Question: Write a single sentence explaining what this figure depicts.
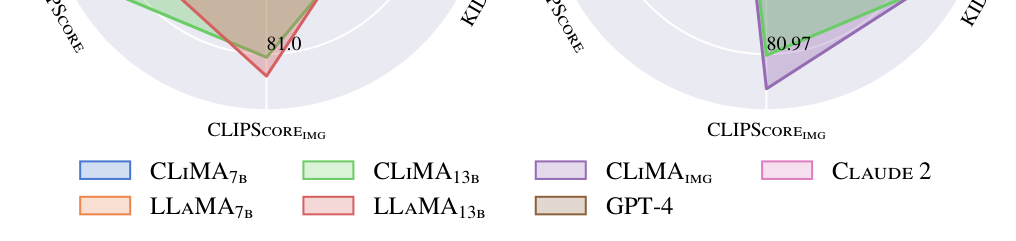
Answer: Automatic evaluation results for LLaMA7b/13b, CLiMA7b/13b/img, GPT-4, and Claude 2. Axes representing metrics where lower values are better (CSR, EED, and KID) have been inverted. Detailed scores are provided in Appendix C for further reference.